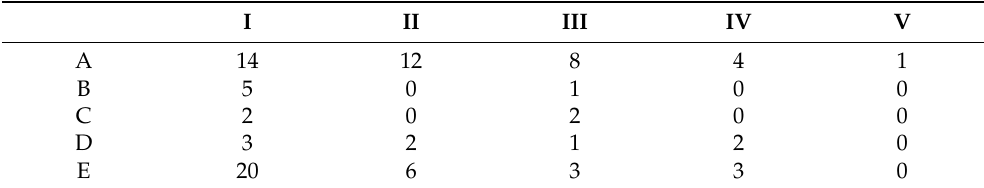
Table 2. Quantity of Zhejiang Province county-level cities belonging to each change type of population and NTL